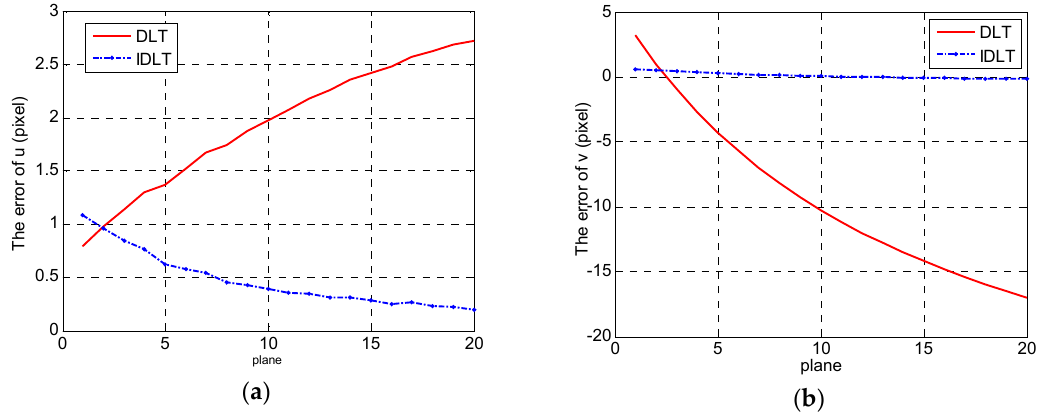
Figure 9. Re-projection errors of 20 planes with DLT and IDLT calibration results: ( a ) u of projection image errors; ( b ) v of projection image errors.